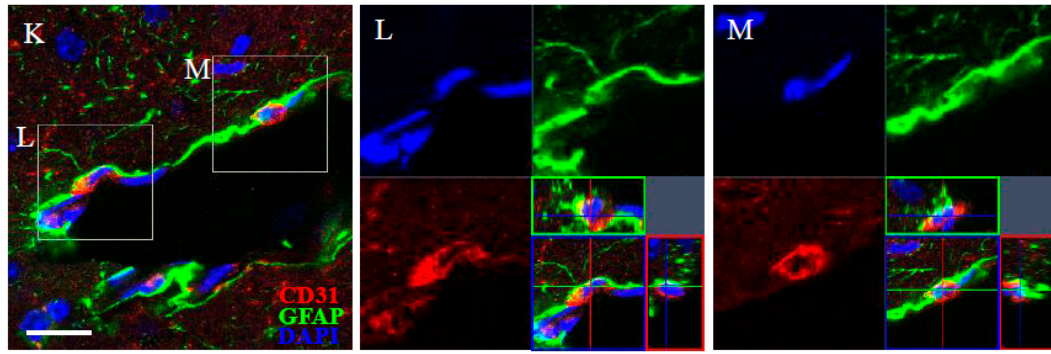
Figure 3. The Combination of MSCs and an EE enhanced endogenous angiogenesis in the striatum. ( A – J ) Two and eight weeks after an EE and MSC transplantation, the amounts of α -SMA + cells ( A ) and CD31 + cells ( B ) were quantified using the MetaMorph Imaging System. Red color indicates α -SMA + cells ( C – F ) and CD31 + cells ( G – J ). The density of: ( A ) striatal α -SMA + cells (%) was significantly higher in the MSC-EE mice than in the PBS-CON, PBS-EE, and MSC-CON eight weeks after treatment (white arrows); and ( B ) CD31 + cells were significantly higher in striatum of the MSC-EE mice than in those of the other groups at eight weeks post-treatment (* p < 0.05, ** p < 0.01, and *** p < 0.001, respectively; n = 5 each); ( C – J ) Eight weeks after EE and MSC transplantation, representative images are shown. Scale bar = 50 µ m; ( K – M ) CD31 + cells (red color) were surrounded with GFAP + astrocytes (green color). Blue color indicates DAPI-positive nuclei. Scale bar = 20 µ m. Values represent mean + SEM.